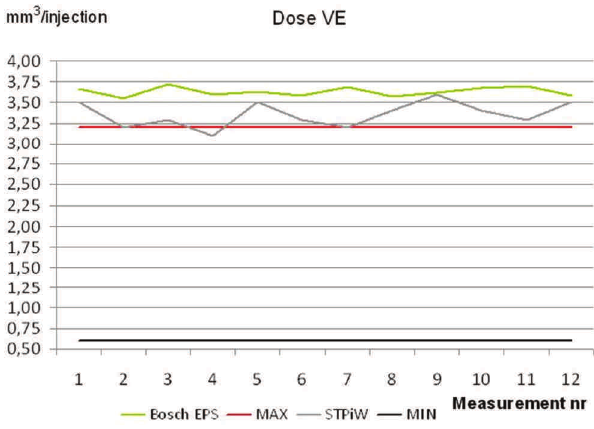
Fig. 9. VE test (actuation time 160 µs, pressure 80 MPa)